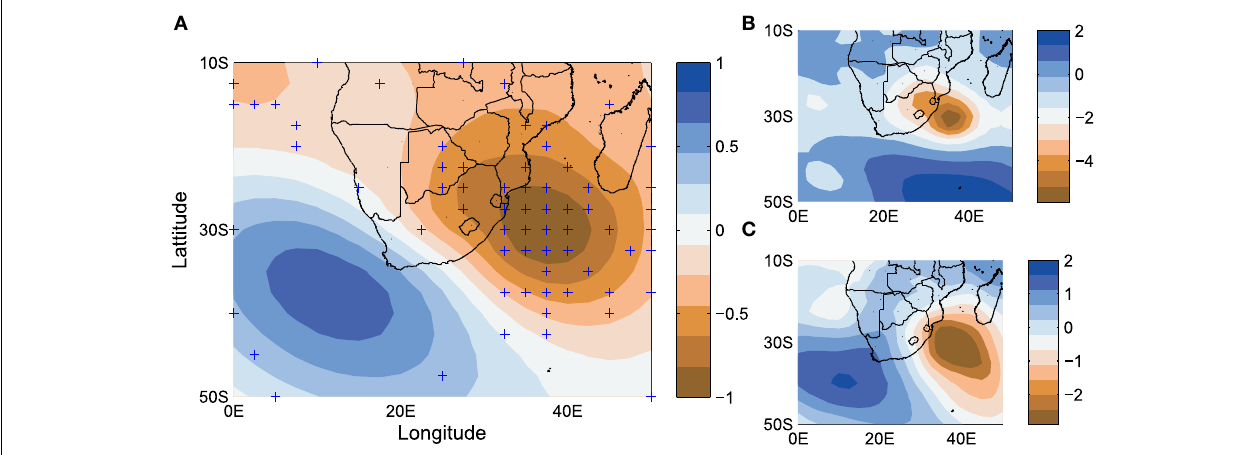
FIGURE 7 | (A) Average anomaly pattern CP03 with ( + ) symbols indicating the centers of all negative anomalies (low pressures) contributing to the class. (B,C) show actual CP’s for the dates 19/03/2007 and 30/08/2006, respectively, both of which were classified as members of the CP03 class.